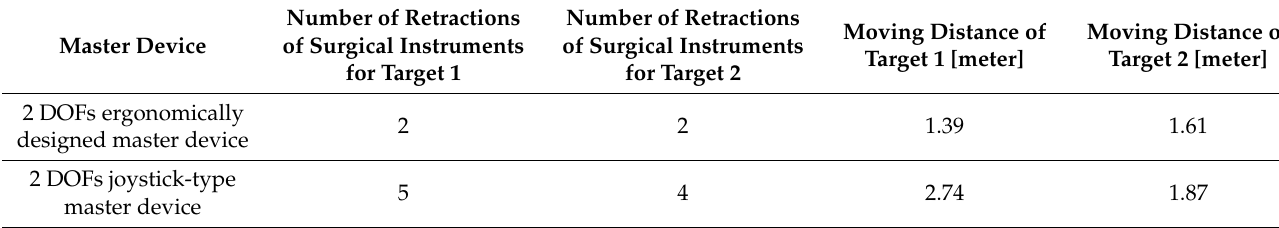
Table 4. Moving distance and the number of retractions of surgical instruments (mean) for right renal artery.